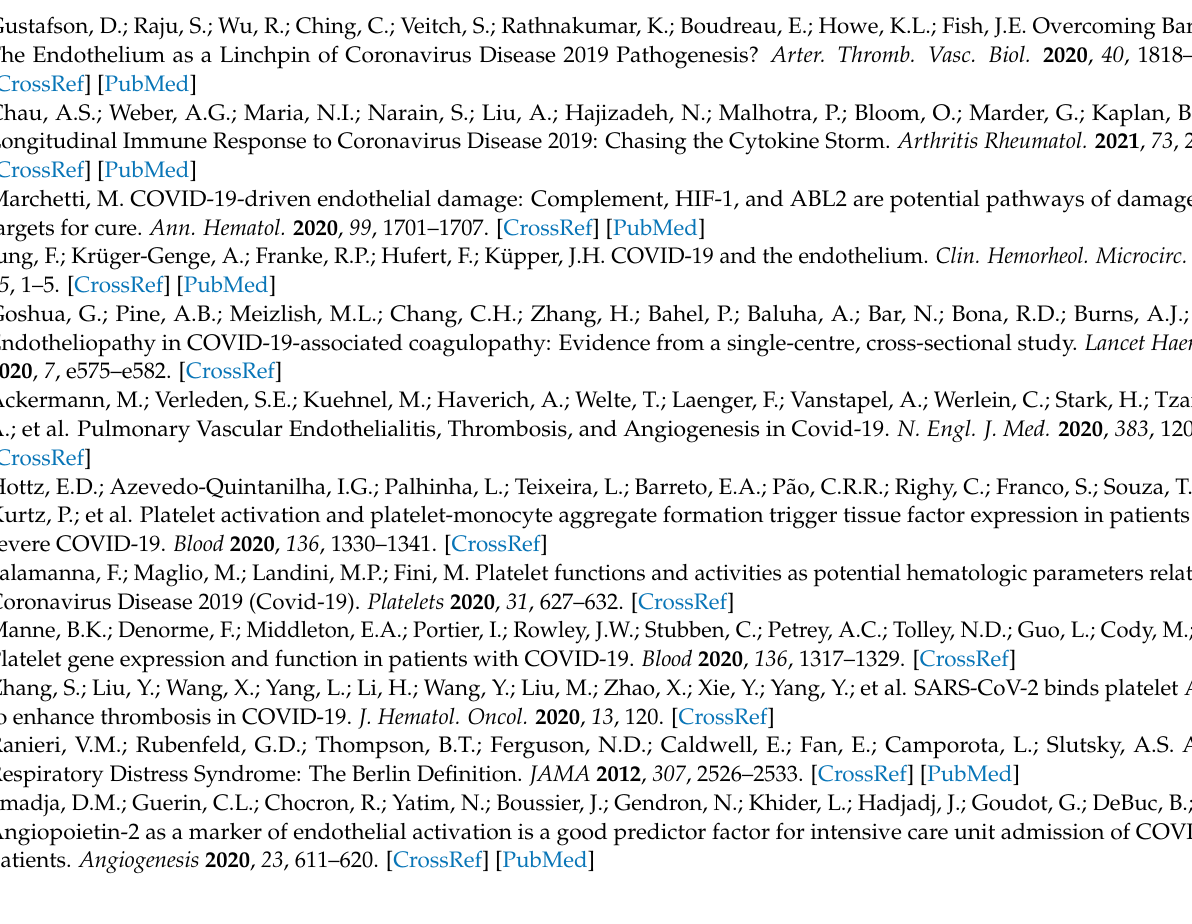
Table S2: Demographics, clinical characteristics, and endothelial biomarkers on hospital admission of ICU and non-ICU